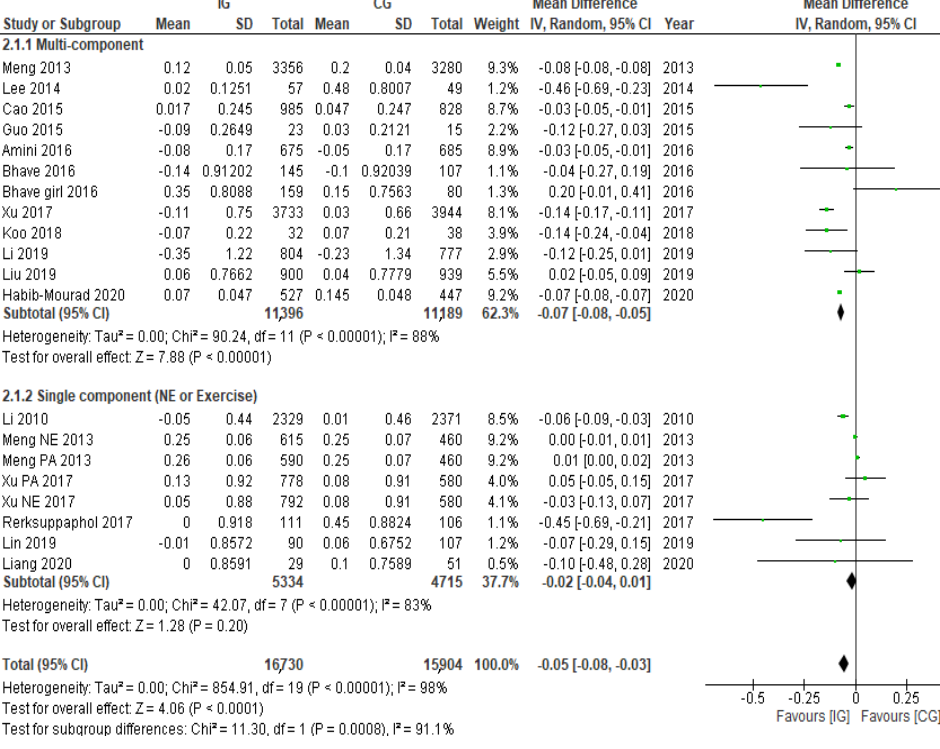
Figure 4. Pooled effects on BAZ and the difference between multi-component interventions and single component interventions.